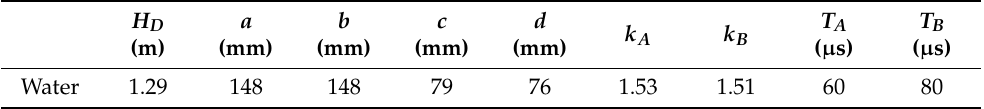
Table 5. X-ray test layout